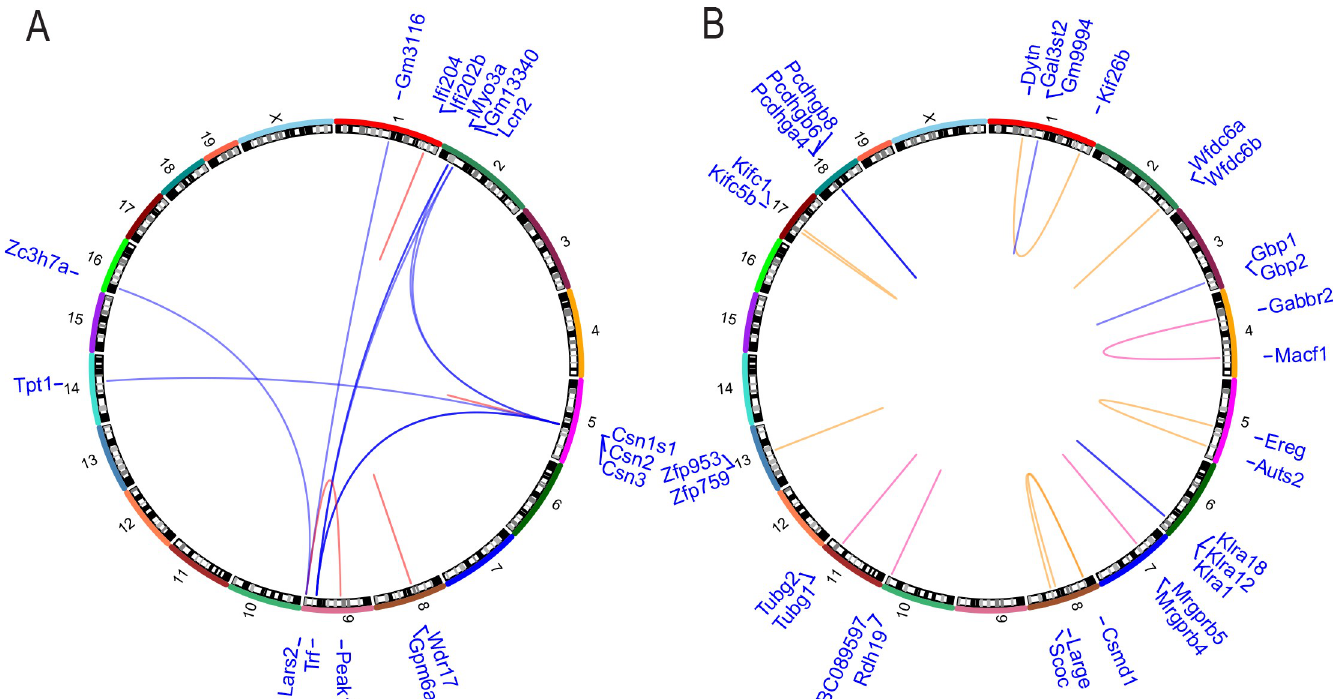
Fig 6. Metastasis-specific structural variants do not drive metastasis in pre-clinical breast cancer mouse models. A . Circos plots representing deFuse2 analysis of RNA-seq data for the 41 matched primary and metastatic PyMT tumors. B. BreakDancer algorithm analysis of 10x WGS data from 20 matched pairs of primary and metastatic lesions from FVB/NJ PyMT x MOLF/EiJ and FVB/NJ PyMT x CAST/EiJ animals. For both plots, the names of the genes associated with predicted structural variations are listed in blue in the outermost track by their corresponding chromosome numbers, which are found in the second track. The inner loops represent breakpoints within repetitive elements at both sites (pink loops), repetitive element at one site (tan loops), or within single copy sequence at both sites (blue loops).